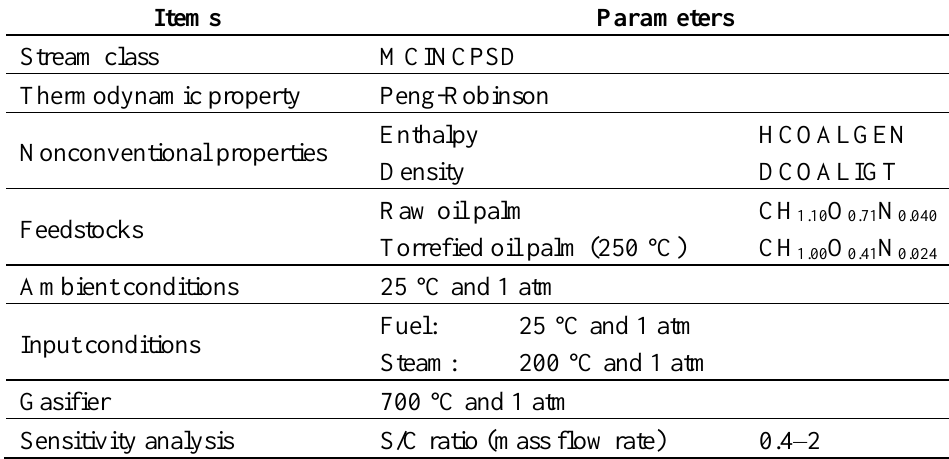
Table 4. Simulation of operating condition and gasification